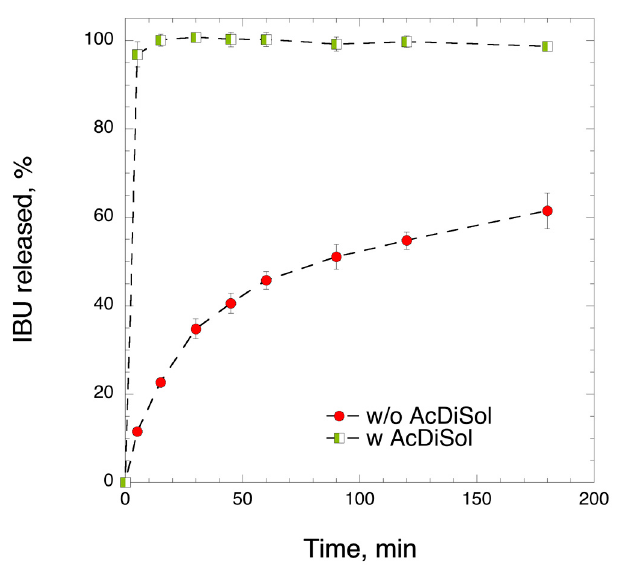
Figure 5. Effect of AcDiSol (superdisintegrant) on IBU release from directly compressed 20% w / w IBU-CLAD tablets (400 mg IBU). The results are the average of three measurements with standard deviation as error bars.